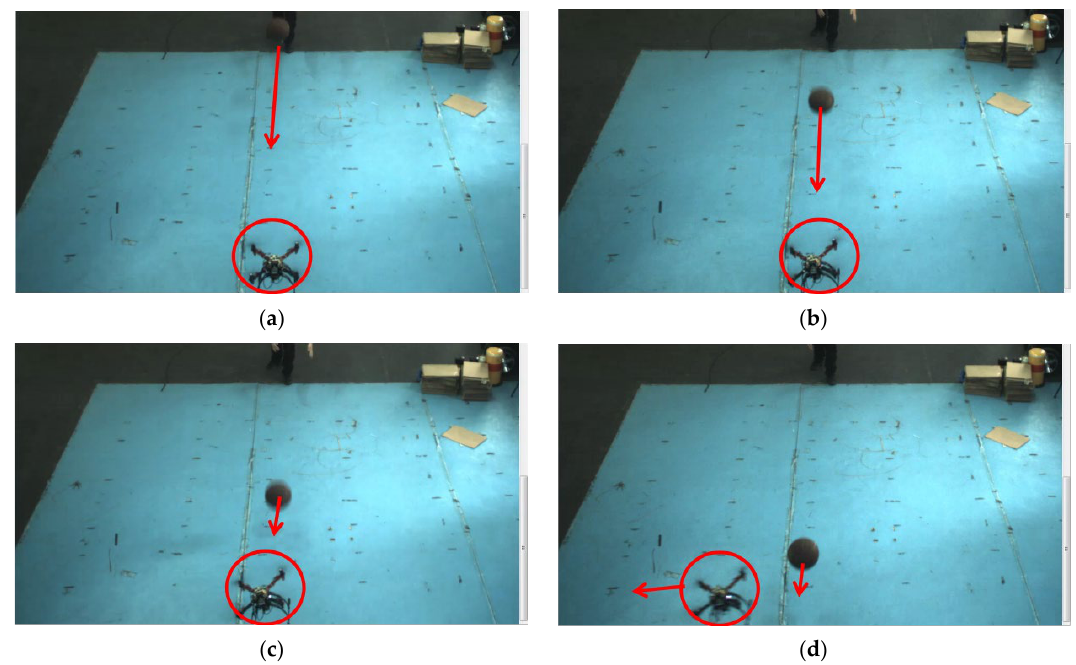
Figure 17. Four images during UAV’s avoiding: ( a ) The basketball is thrown from 3–5 m in front of the UAV; ( b ) The basketball approaches the UAV; ( c ) The UAV moves left; ( d ) The UAV avoids the flying basketball successfully.